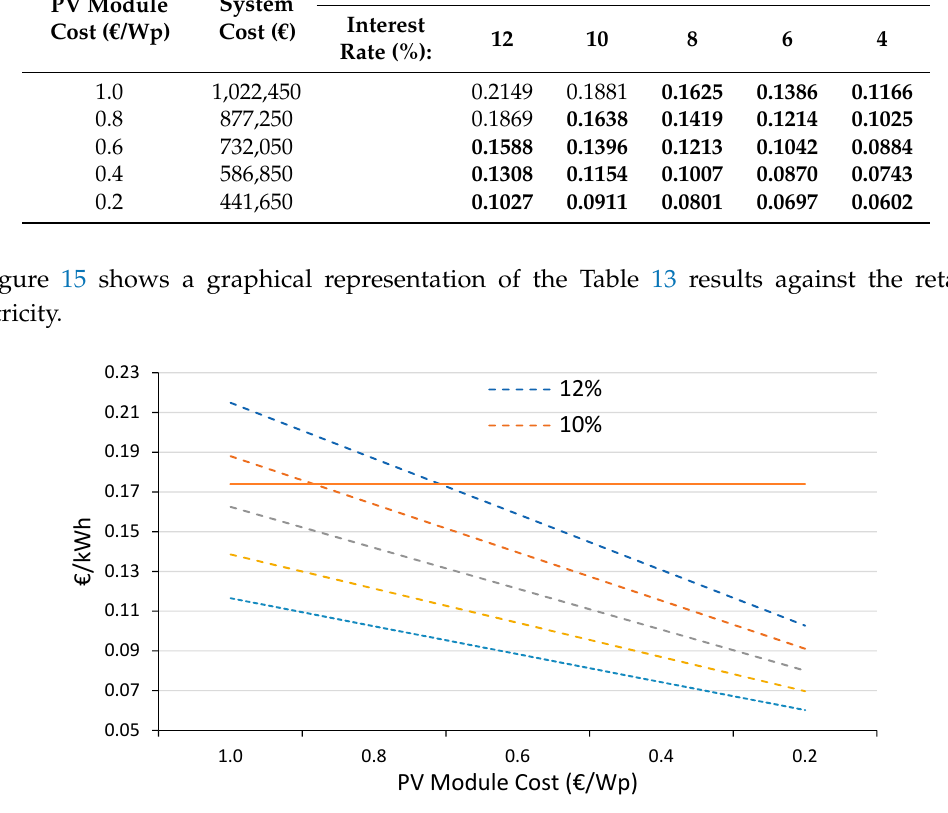
Table 14. Comparison of the LCOE based on the different annual yield for 500 kW.